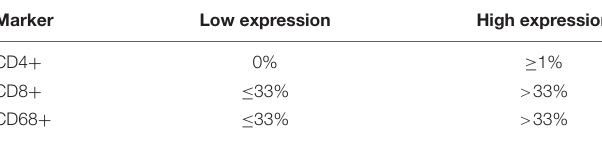
TABLE 1 | Definition of low and high expression of different inflammatory cell